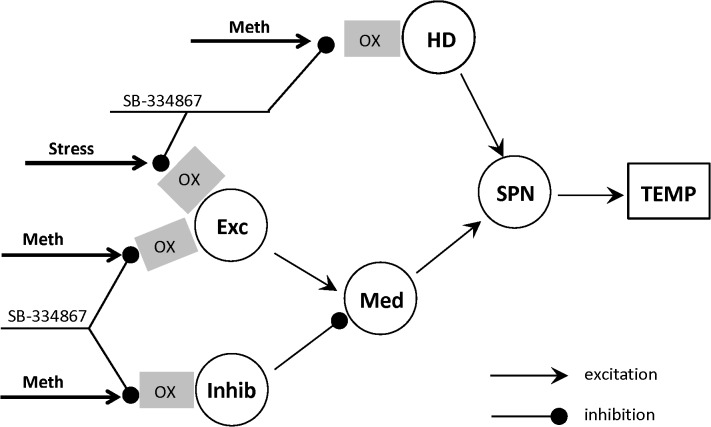
Schematic of the model neuronal circuitry involved in responses to methamphetamine.Stress input and the orexin receptors (shown by gray rectangles labeled “OX”) are added to extend the circuitry used in [30]. Effect of Stress and/or Meth can be affected by the orexin receptor antagonist SB-334867. Each circle represents a neural population. Abbreviations: Exc—excitatory node, Inhib—inhibitory node, HD—high-dose activated node, Med—medullary node, SPN—sympathetic preganglionic node, TEMP—temperature. See text for a detailed description.